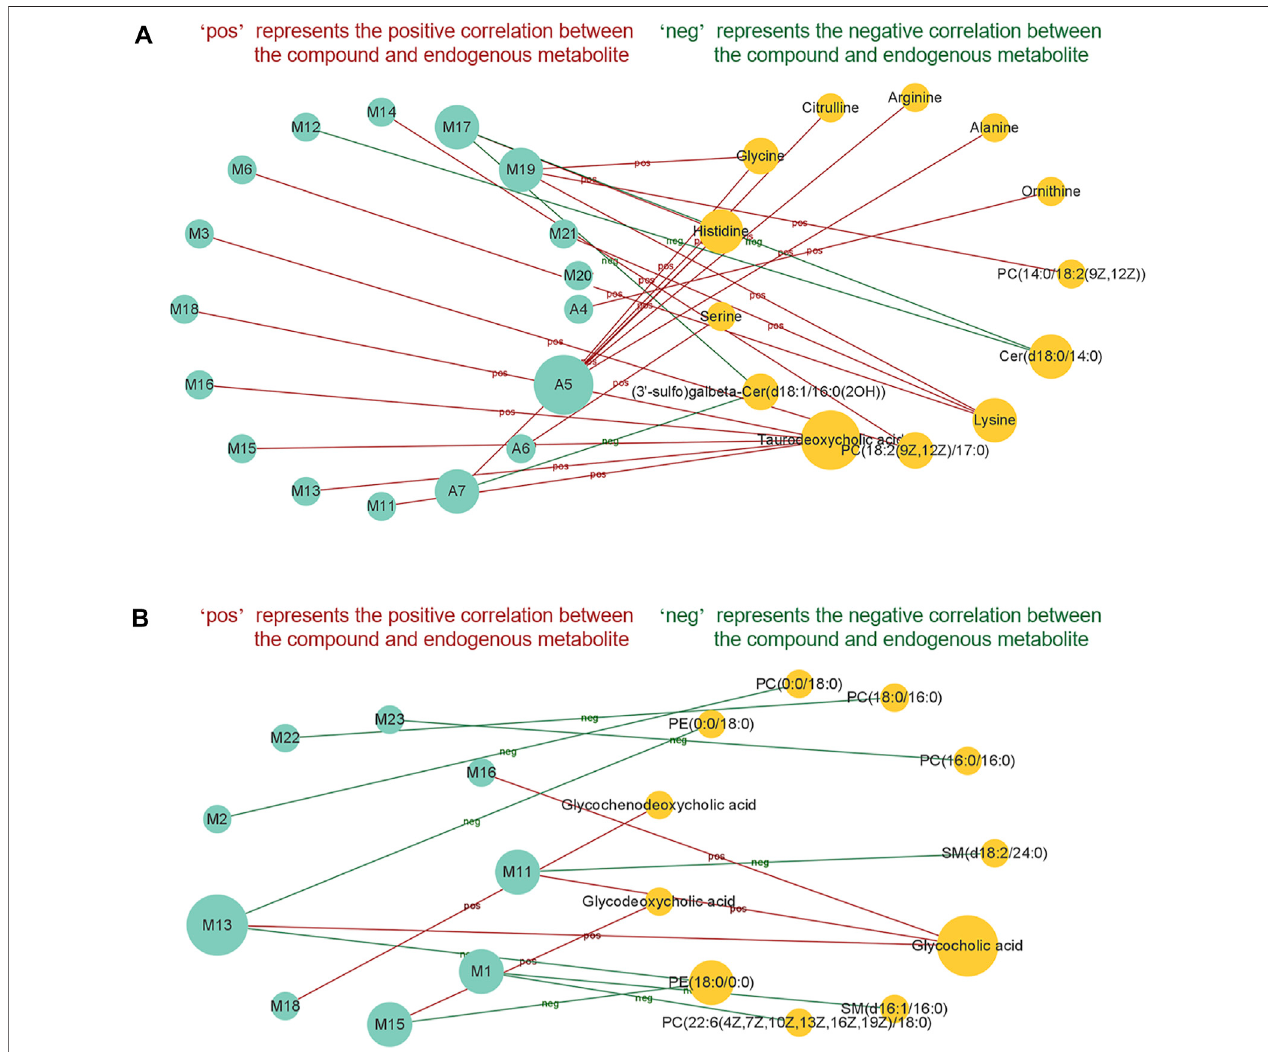
FIGURE8| ThecorrelationshipbetweenpotentialeffectivesubstancesandendogenousmetabolitesinEHLBSstage (A) andBSstage (B) .Onlypotentialeffective substances and endogenous metabolites with signi fi cant correlation were shown in this fi gure. Green circle represents potential effective substance; orange circle represents endogenous metabolite. There is a signi fi cant correlation ( p < 0.05) between the potential effective substance and endogenous metabolite, which are connected by a solid line.